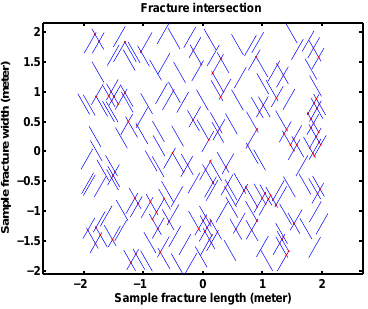
Figure 5. The fracture intersection points of discrete fracture networks.